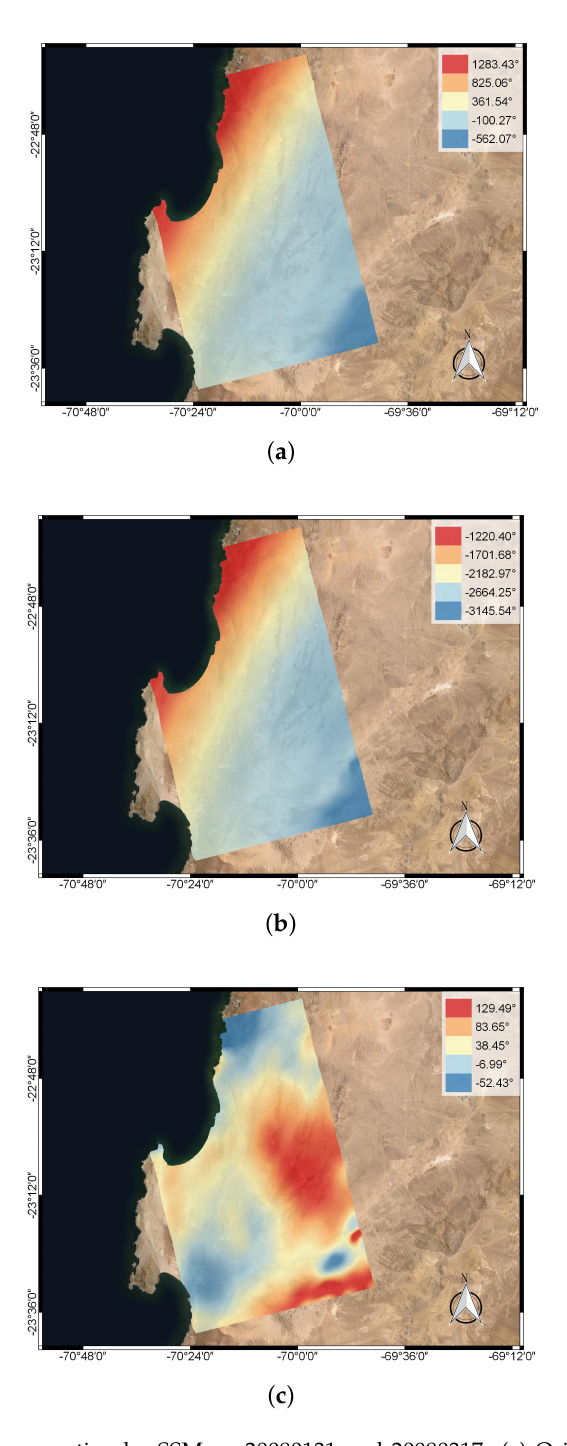
Figure 9. Ionospheric correction by SSM on 20080131 and 20080317: ( a ) Original DInSAR phase. ( b ) Ionospheric phase delay. ( c ) Corrected DInSAR